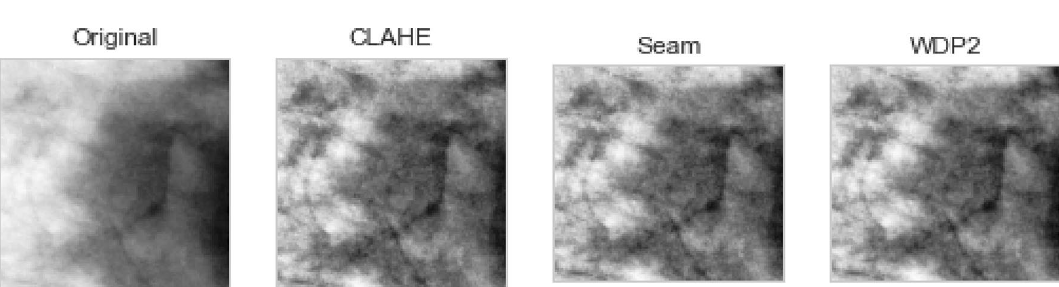
Figure 10. Samples of images to demonstrate the improvement resulting from preprocessing all image inputs using the enhancement technique CLAHE.